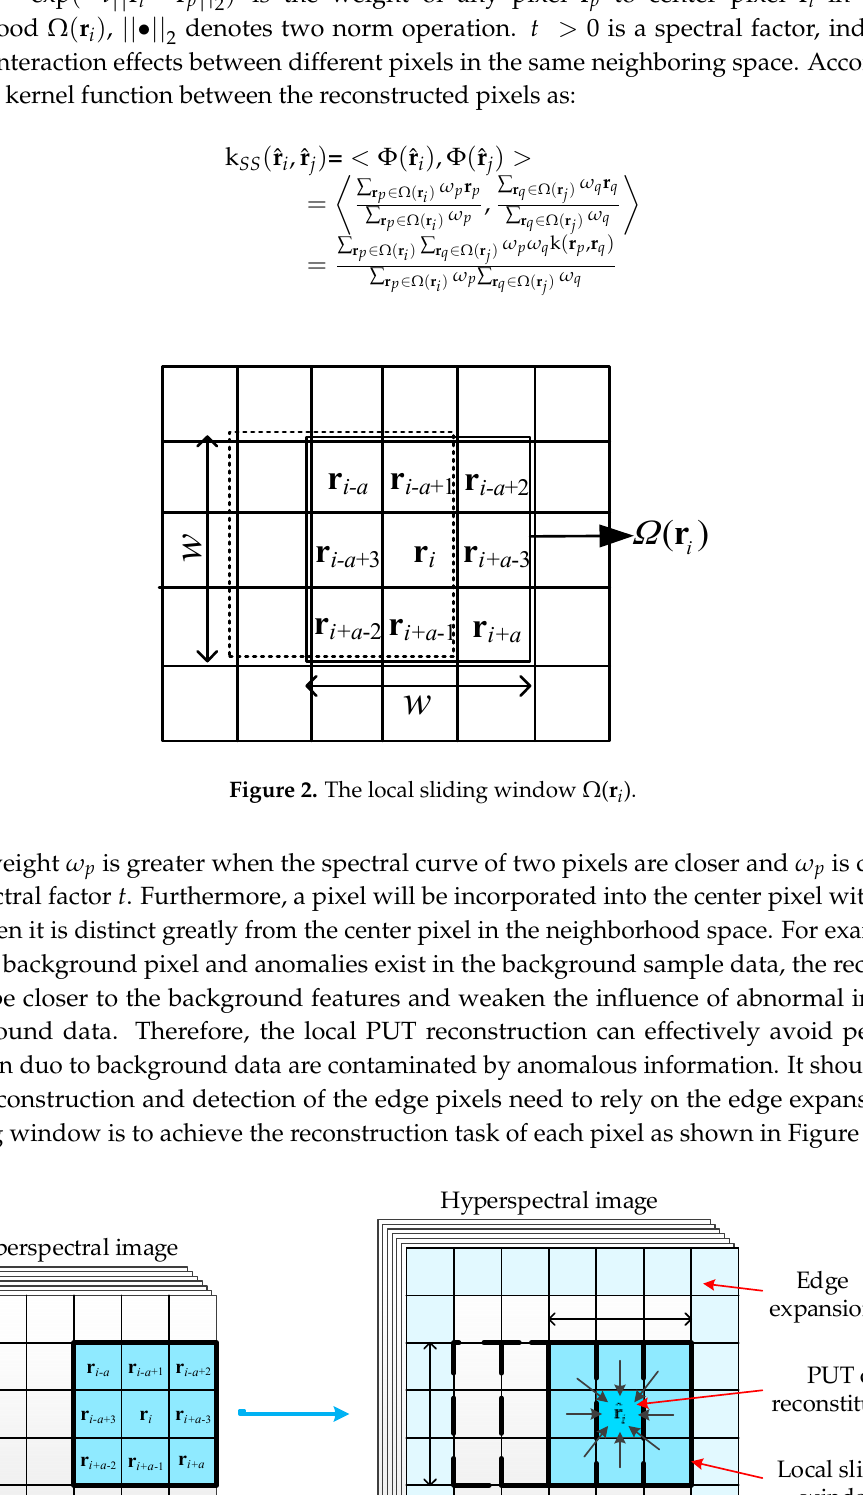
Figure 3. Illustration of information reconstitution.